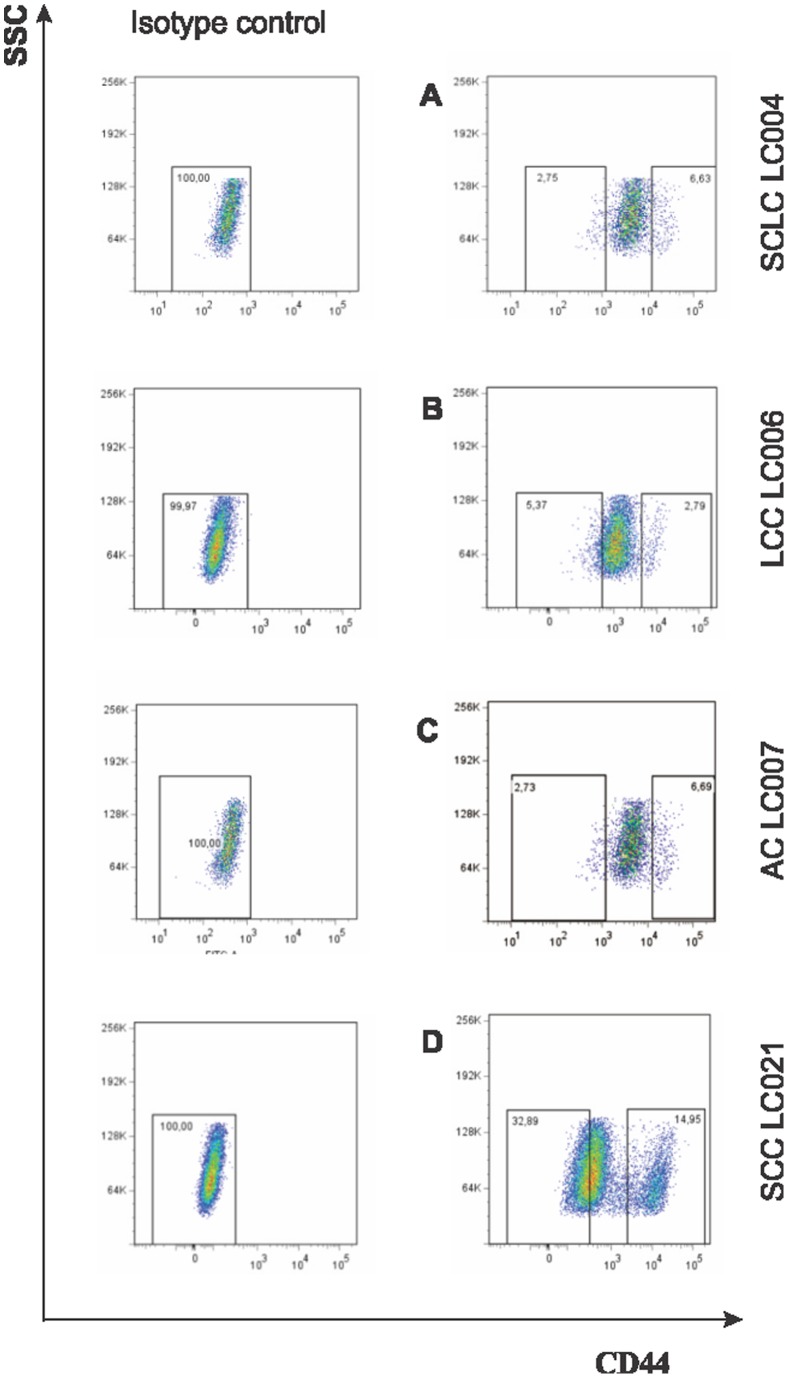
Identification of CD44high cells in the PLCCLs by flow cytometry analysis.A small sub-population of CD44high cells could be identified in the SCLC cell line LC004 (6.63%) (A); the LCC cell line LC006 (2.79%) (B); the AC cell line LC007 (6.69%) (C) and the SCC cell line LC021 (14.95%) (D), respectively. Left panel: isotype control Ab; right panel: CD44 Ab. Data shown are from representative experiments (n>3).